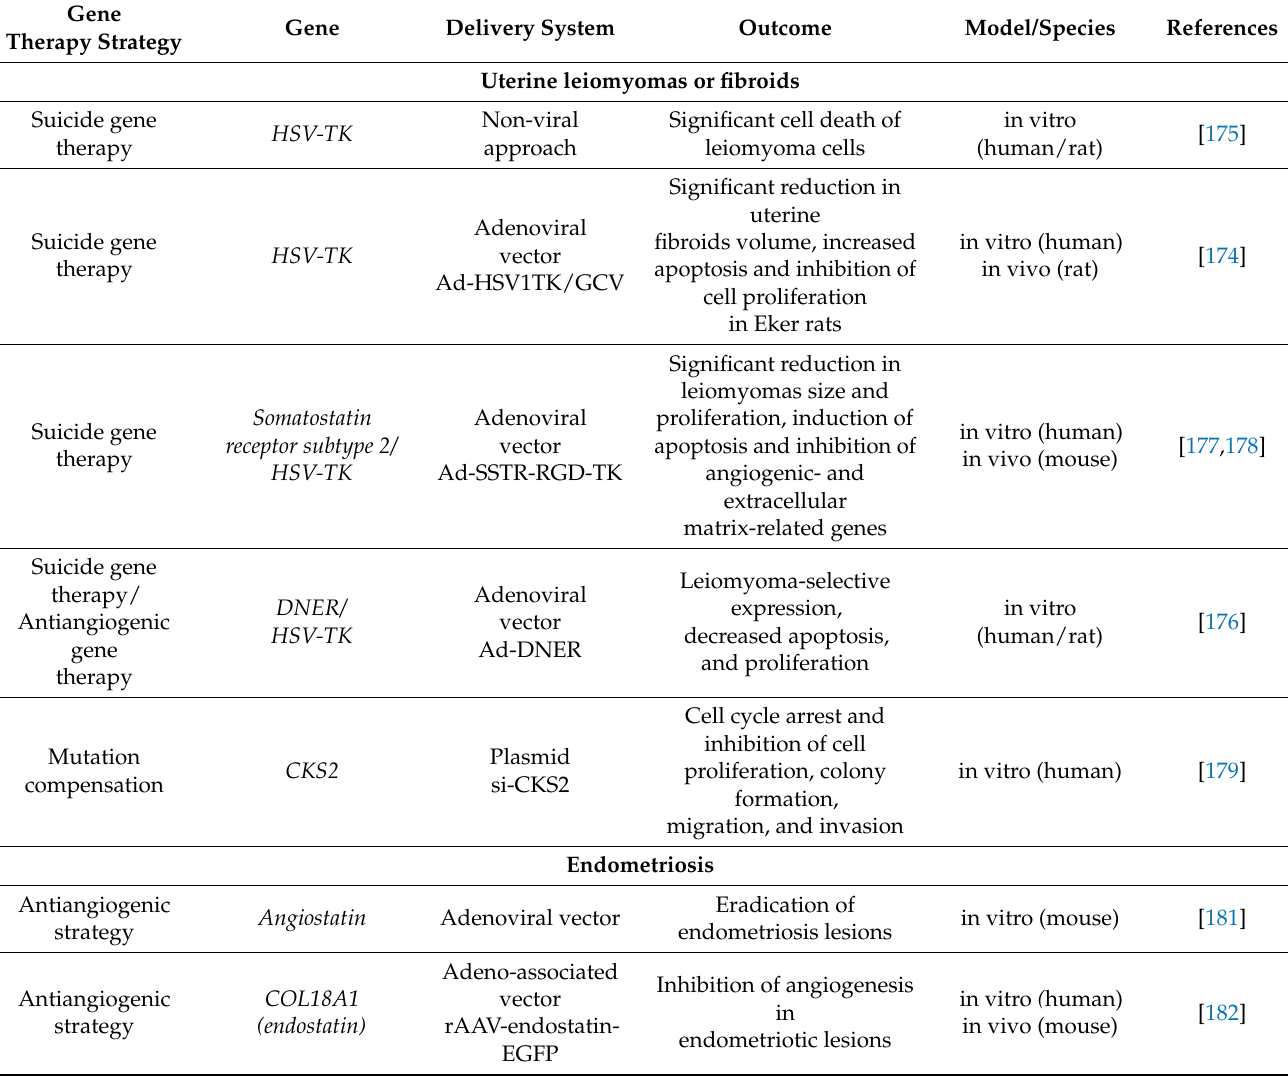
Table 3. Targeted gene therapy approaches for benign gynaecological